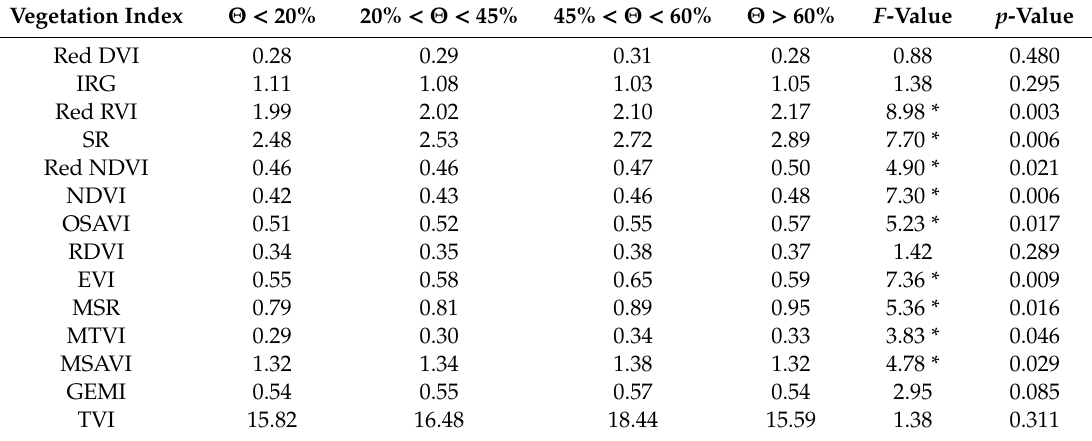
Table 4. Analysis of variance for Cerastium vegetation indices for di ff erent water content levels ( Θ ). Vegetation Index Red DVI